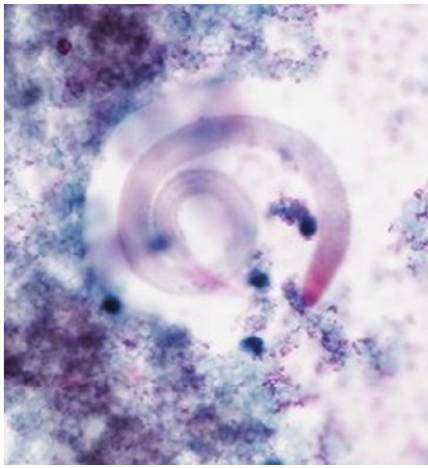
Figure 1: BAL specimen showing adult worm.